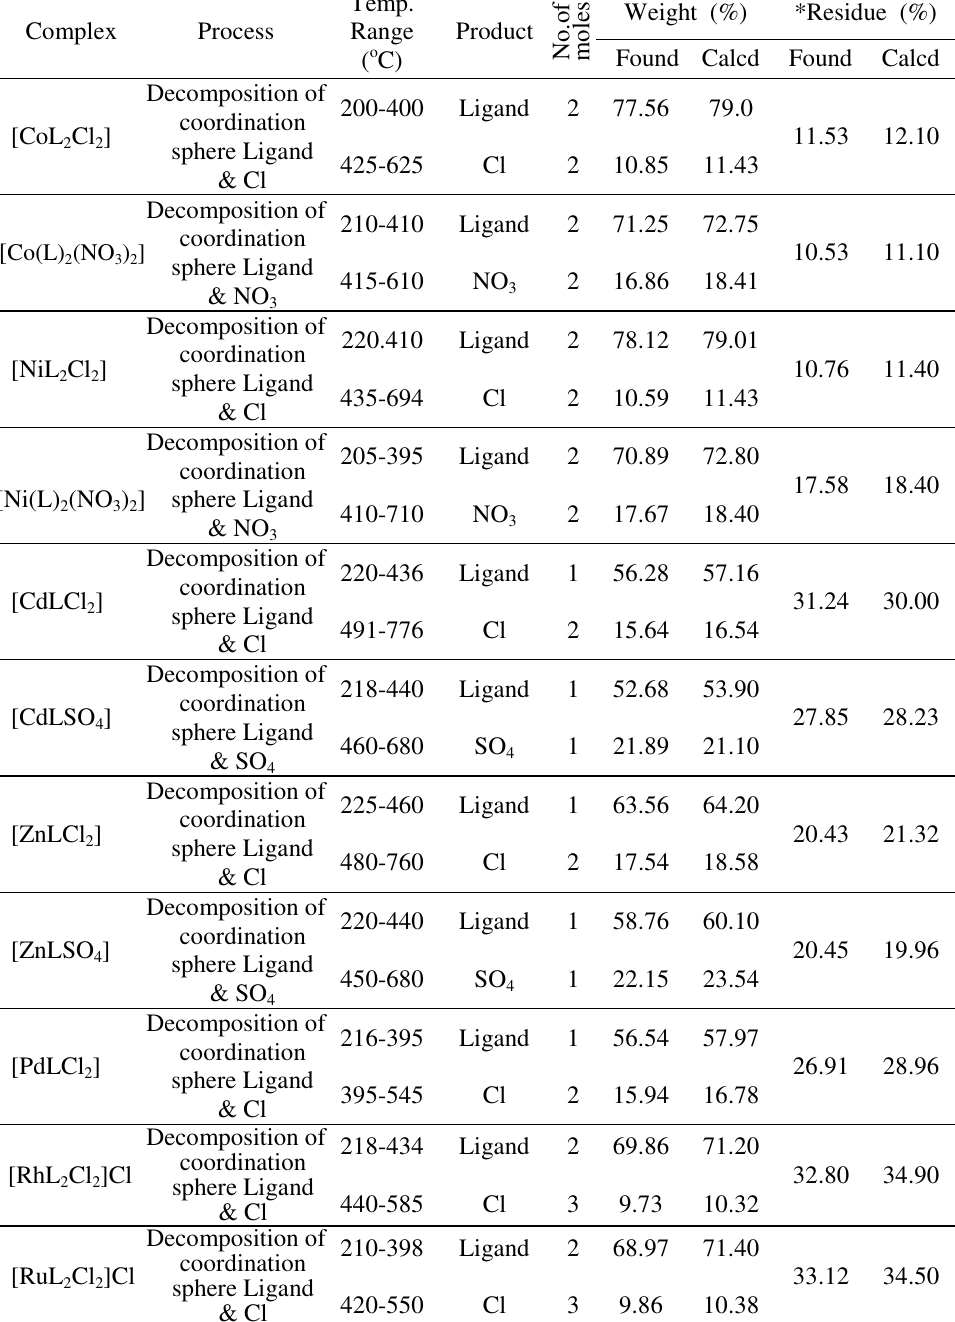
Table 3. Thermogravimetric characteristics of complexes